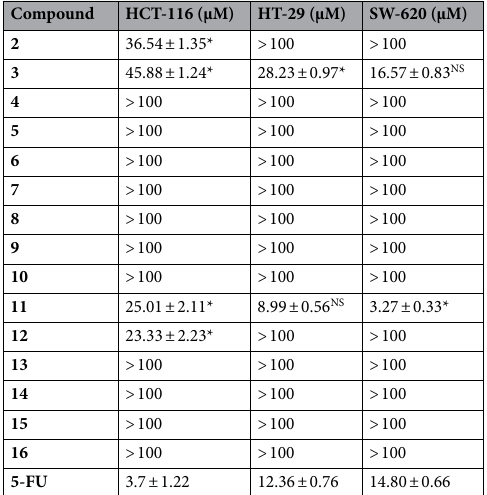
Table 1. IC 50 values (µM) for the 15 compounds compared to 5-FU on the three colon cancer cell lines. Results are average of triplicate experiments ± SEM. *Significantly different from 5-FU; NS not significant, p <